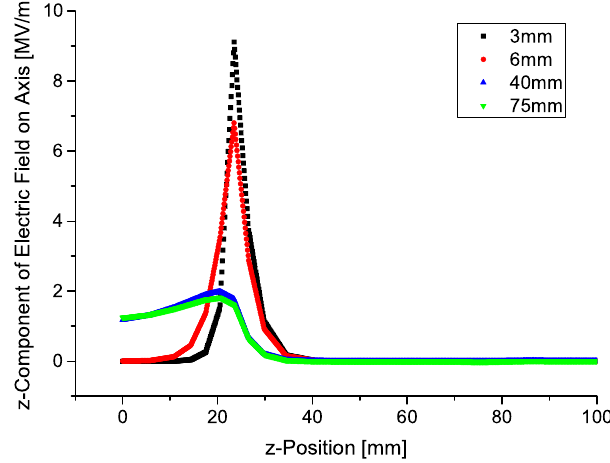
FIG. 21. z -component of electric field on axis with variation of the inlets opening radius. This variation has a strong influence on the gap field of the four-rod structure. By opening the aperture of the rf shielding, a reduction of the peak by a factor of 4.5 can be achieved.